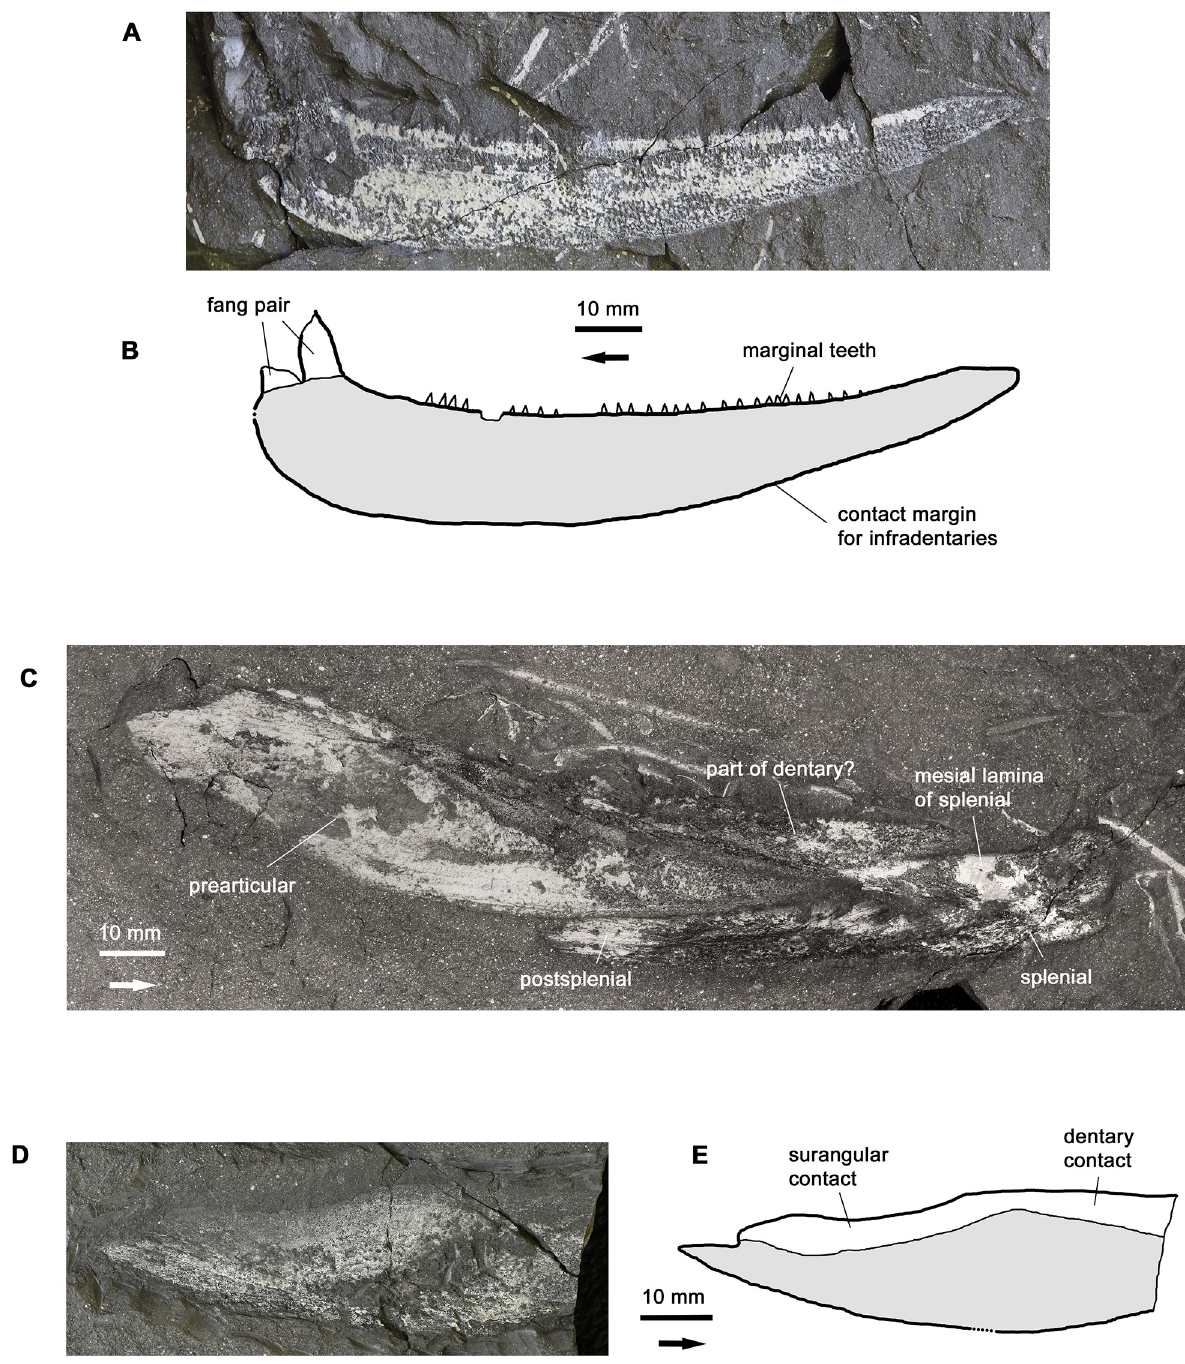
Fig 6. The lower jaw. A-B, photo and interpretative drawing of dentary AM6502a. C, labelled photo of lower jaw ramus AM18000a. D-E, A-B, photo and interpretative drawing of angular AM5668. Graphic conventions as in Fig 4.